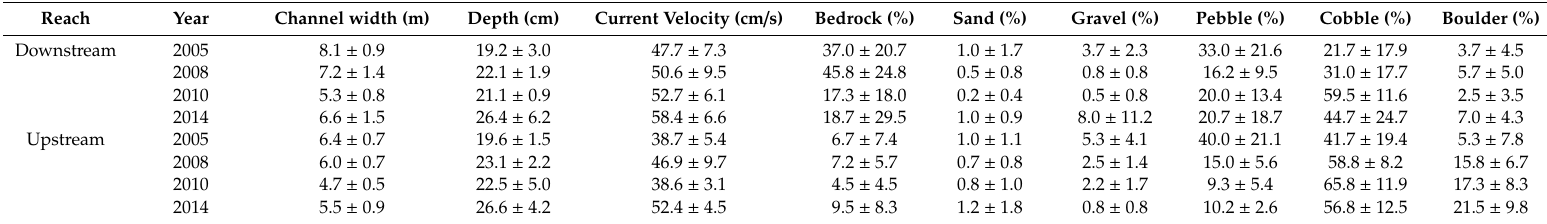
Table 1. Physical environments (mean ± standard deviation) in the downstream (down) and upstream (up) reaches of the dam in the Ikeshomanai Stream before (2005 and 2008) and after (2010 and 2014) dam